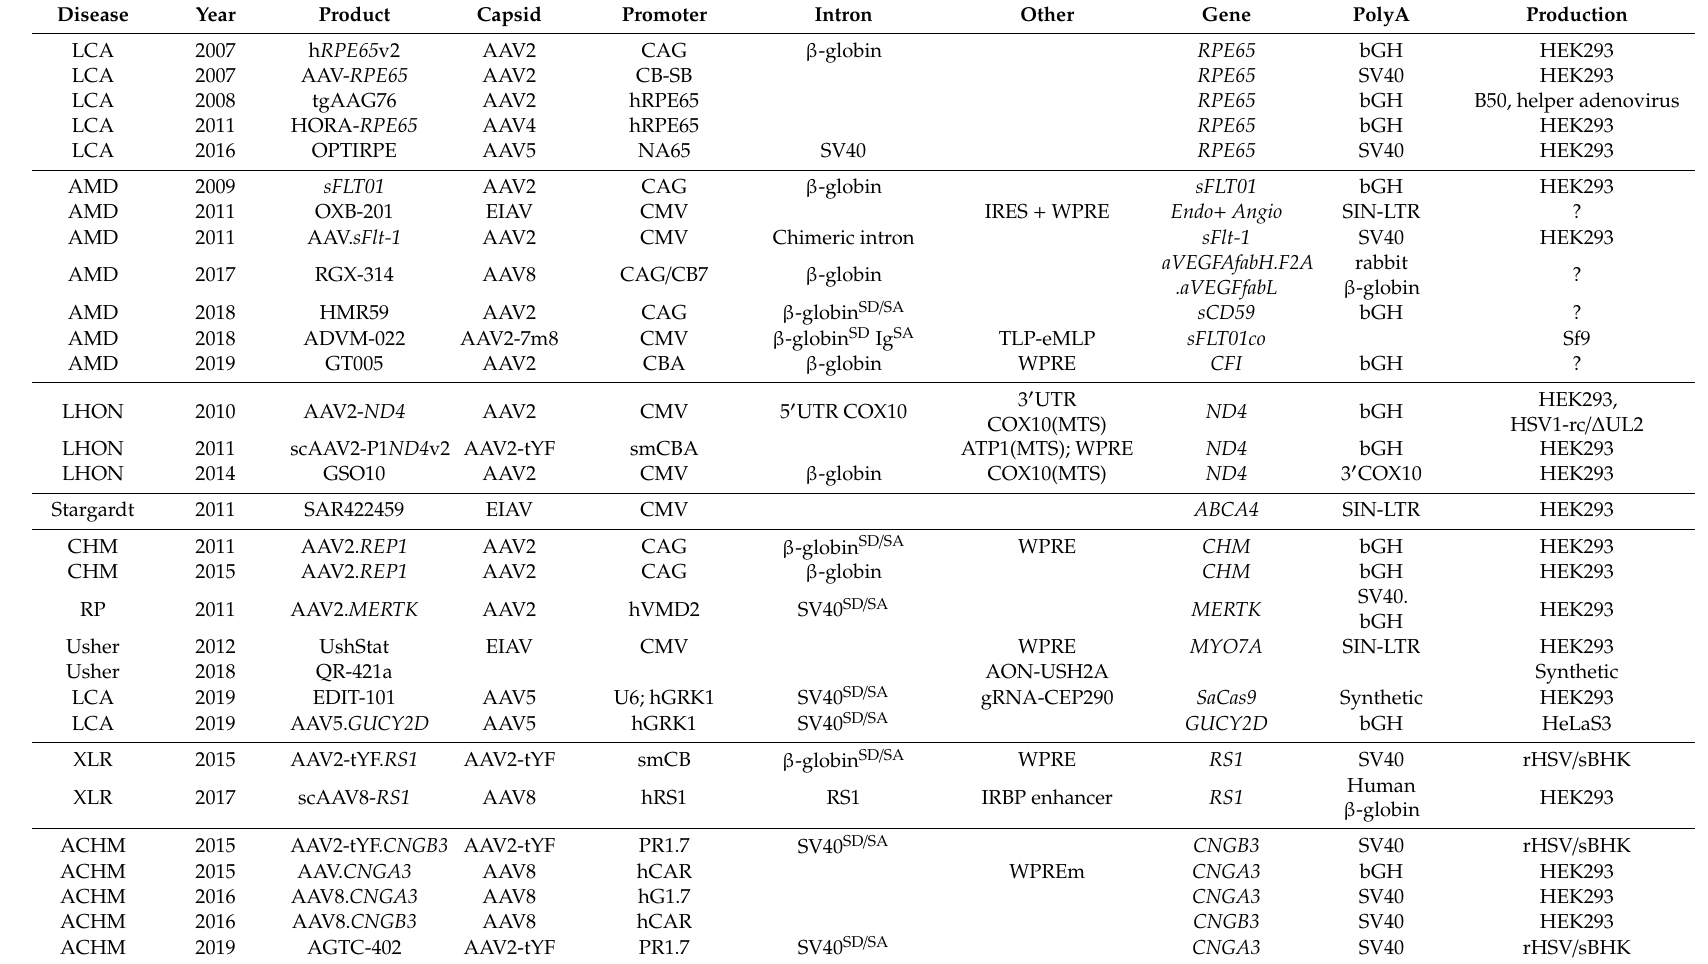
Table 1. rAAV gene therapy products registered on